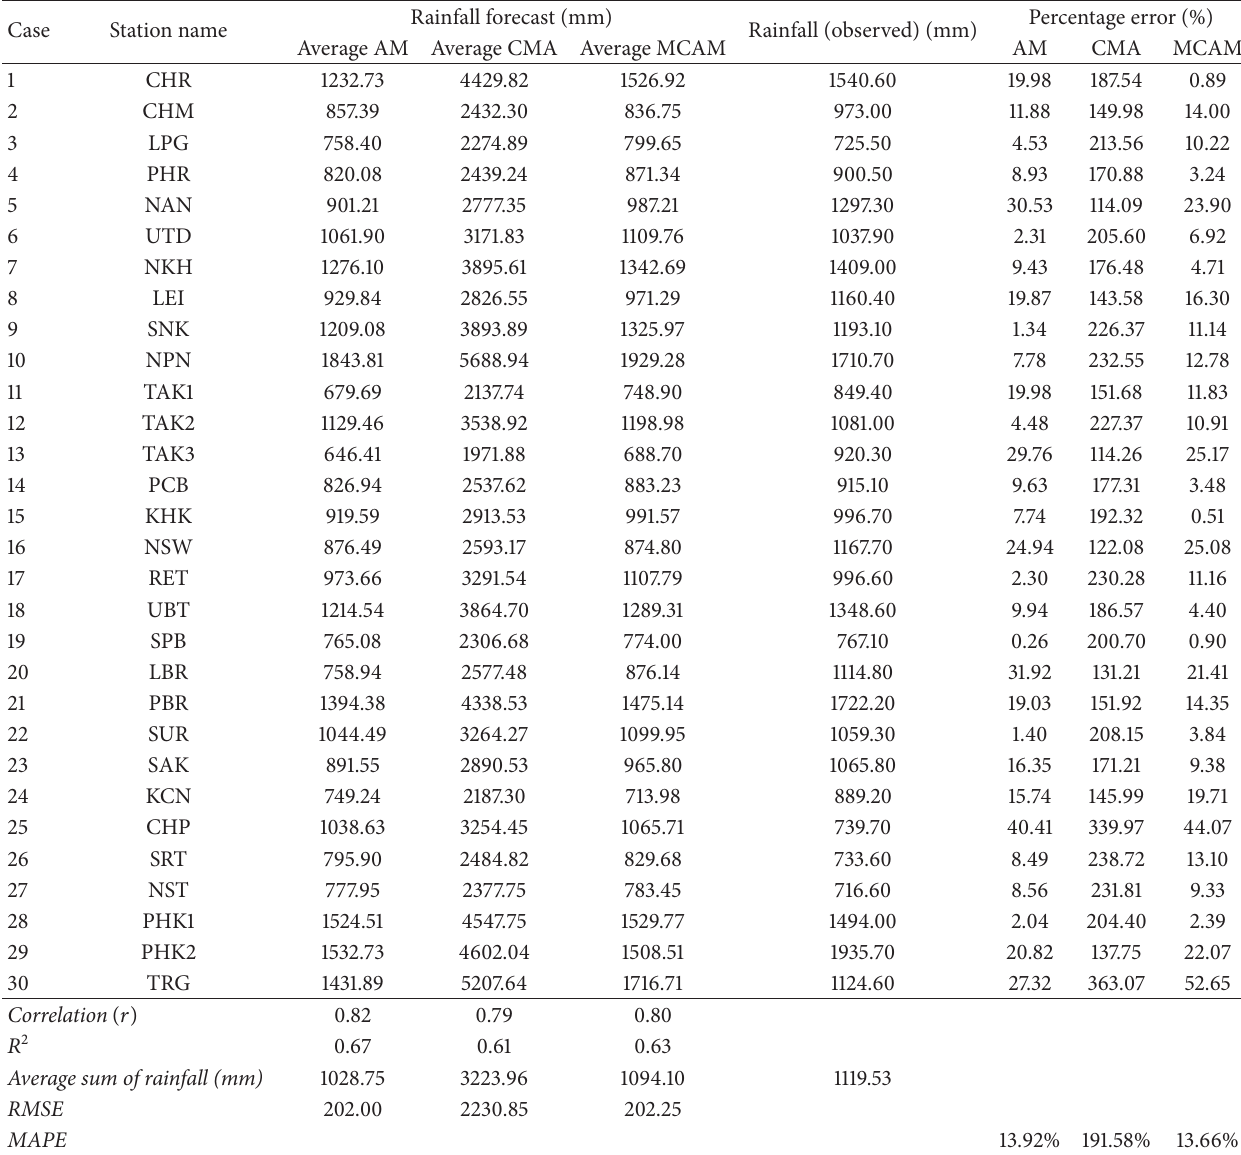
Table 7: Correlation between observed and average rainfall from all predictors by average AM, average CAM, and average MCAM. For forecast predictor during 15 May to 15 October 2010 at 30 stations in